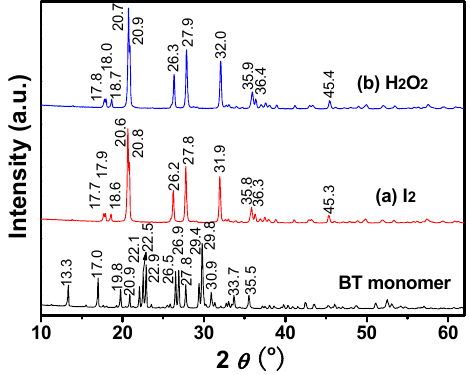
Figure 3. Wide-angle X-ray diffraction (WAXD) diffractograms of BT monomer and PBT polymers prepared with (a) an I 2 /BT molar ratio of 1.5 and an initial BT concentration of 50 mmol L − 1 , and (b) an H 2 O 2 /BT molar ratio of 3.53 and an initial BT concentration of 58.25 mmol L − 1 in ethanol at 25 °C for 24 h.